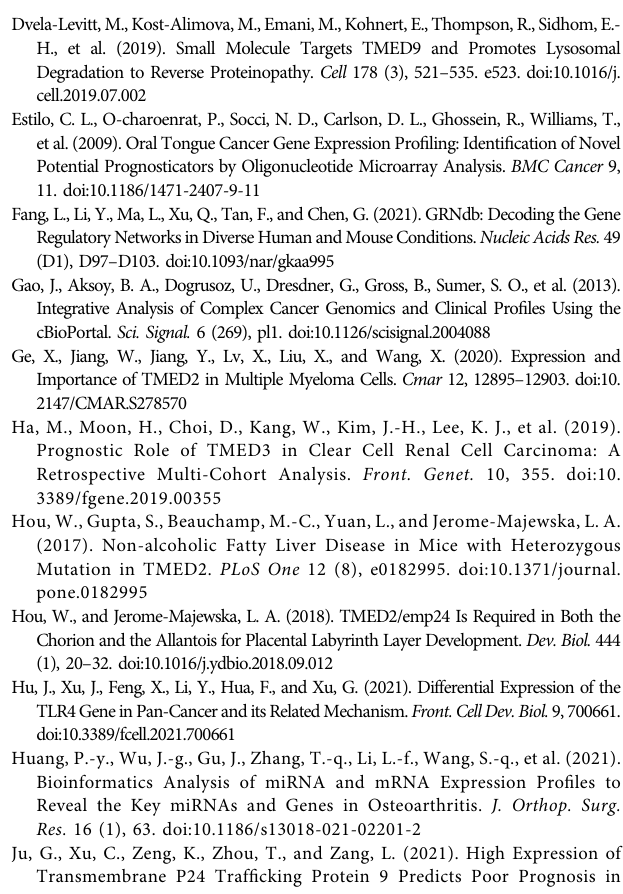
Supplementary Table S1 | Top 10 in-network genes ranked by MCC method. Supplementary Figure S1 | The prognostic value of the TMED family in HNSC patientsisbasedontheGEPIA2database. (A) TMED1; (B) TMED2; (C) TMED3; (D) TMED4; (E) TMED5; (F) TMED6; (G) TMED7; (H) TMED8; (I) TMED9; (J) TMED10. Supplementary Figure S2 | Correlation of TMED2/9/10 expression with immune in fi ltration levels of B cells in